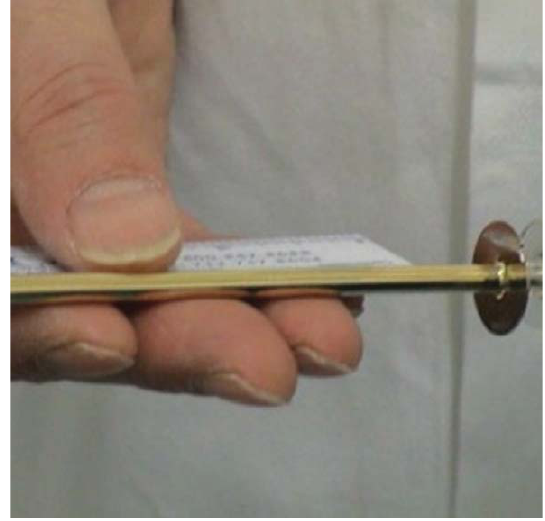
Fig. 5. Gold-made conformal cap used in the improved surgical treatment with